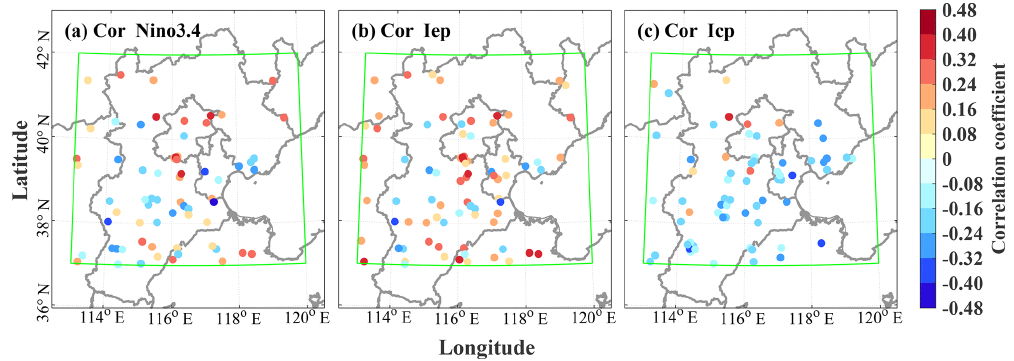
Figure 1. Correlation coefficients between the time series of site-observed winter haze days in the JJJ region and (a) I Niño3.4 , (b) I ep , and (c) I cp indices. The correlations at these sites are significant at the 90% confidence level. The green box represents the domain of the JJJ region (37–42 ◦ N, 113–120 ◦ E) in this study.